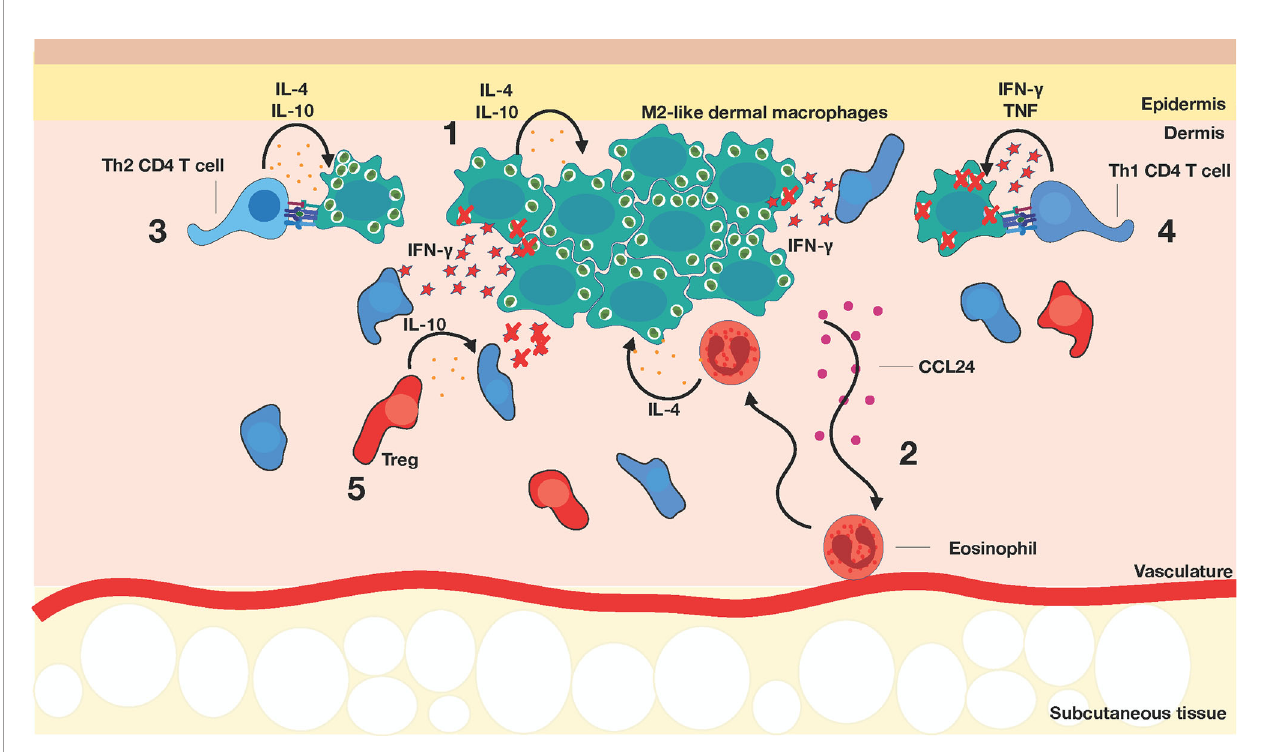
FIGURE 4 | Establishment of chronic Leishmania infection. (1) M2-like dermal macrophages (dark green) harbor parasites. (2) Eosinophils (red) are recruited to the site of infection via CCL24 and produce IL-4 to maintain the M2-like dermal macrophages. (3) Th2 CD4 + T cells (light blue) exacerbate disease progression, while (4) Th1 CD4 + T cells (dark blue) stimulate macrophages to improve leishmanicidal activity, mediated primarily by IFN g production. At this stage of infection, Th1 CD4 + T cells tend to surround but do not enter the lesion. (5) Regulatory T cells (red) are recruited to the lesion site and can suppress Th1 responses, possibly through IL-10